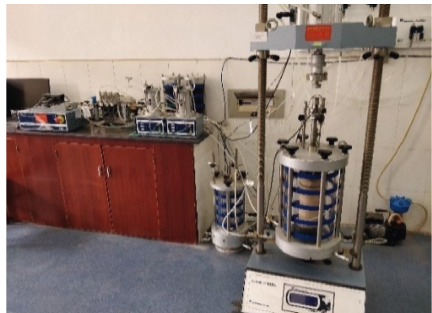
Figure 2: Dynamic triaxial test.